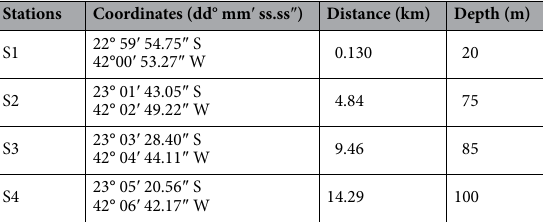
Table 1. Geographic coordinates (datum WGS84), distance from the coast and depth of the stations sampled in this study (S1, S2, S3 and